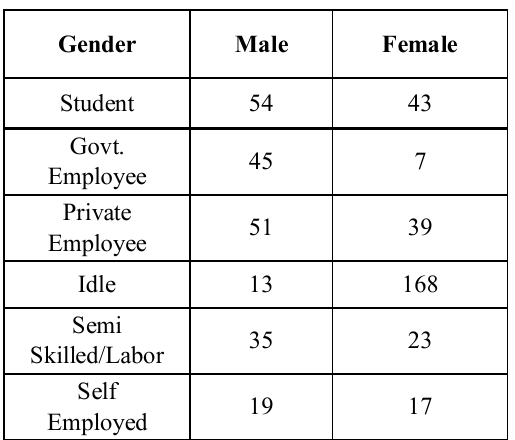
Table: 3 Distribution of Patient according occupation